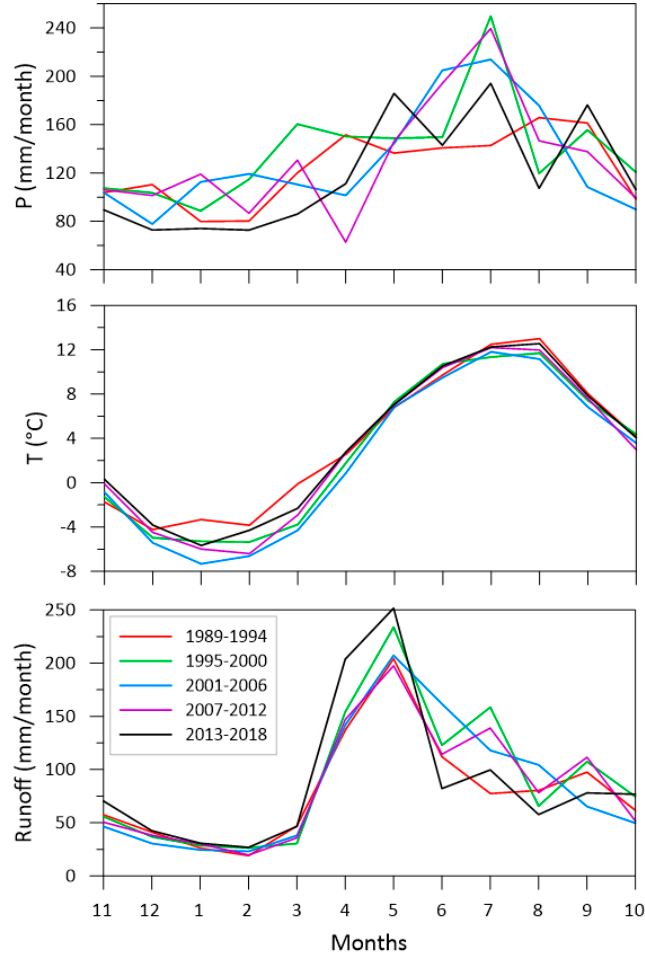
Figure 2. Variability of mean monthly precipitation, air temperature and runoff in five specific periods. Table 1. Mean annual and seasonal characteristics of precipitation (P), air temperature (T), runoff (Q) and snow water equivalent (SWE) in the selected periods. Seasonal characteristics of P and T represent the period from April to October, SWEmax is the mean of SWE maximum in each year.